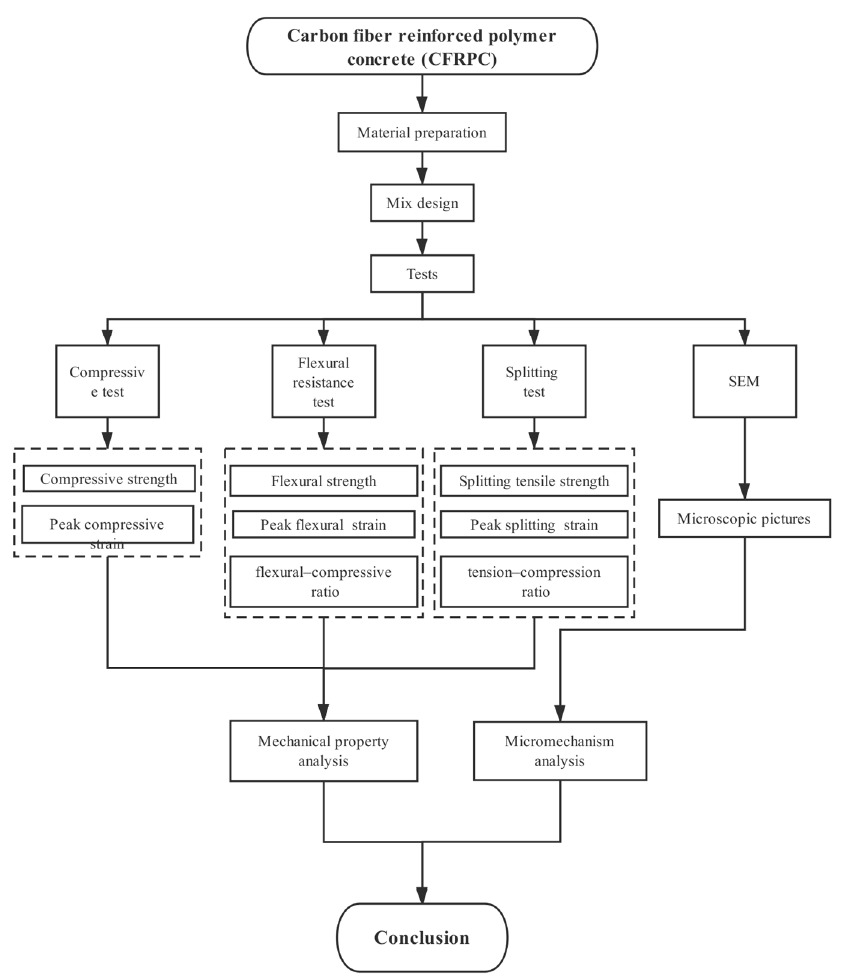
Figure 1. Technical route diagram.